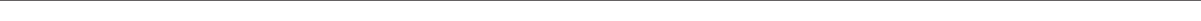
TABLE 2 | Effect of different degree of exposure on the berry mass and composition, and berry skin fl avonoid pro fi le of Cabernet sauvignon grapevine berry at harvest: i) Exp − (non-exposed berries collected from clusters in canopy interior), ii) Exp+ Deg − (exposed but not degraded, collected from Northeast exposed clusters), iii) Exp+ Deg+ (exposed and degraded, collected from Southwest exposed clusters), and iv) Exp+ Deg++ (exposed and very degraded grapes with signs of damage collected from Southwest exposed clusters) and collected in Oakville, CA in 2017. Degree of exposure